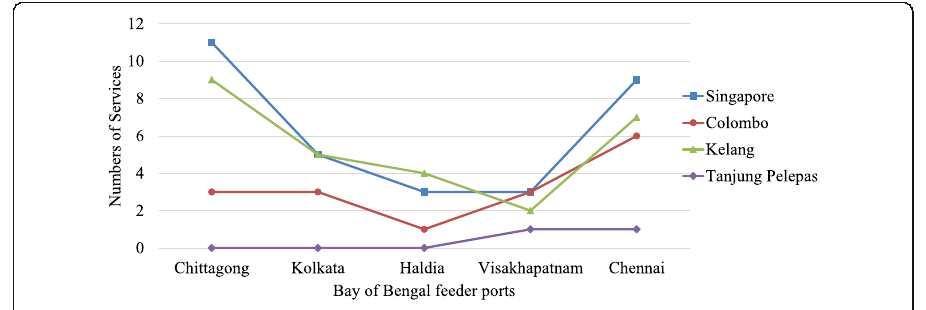
Fig. 3 Number of Common Services Calling Hub and Feeder Ports